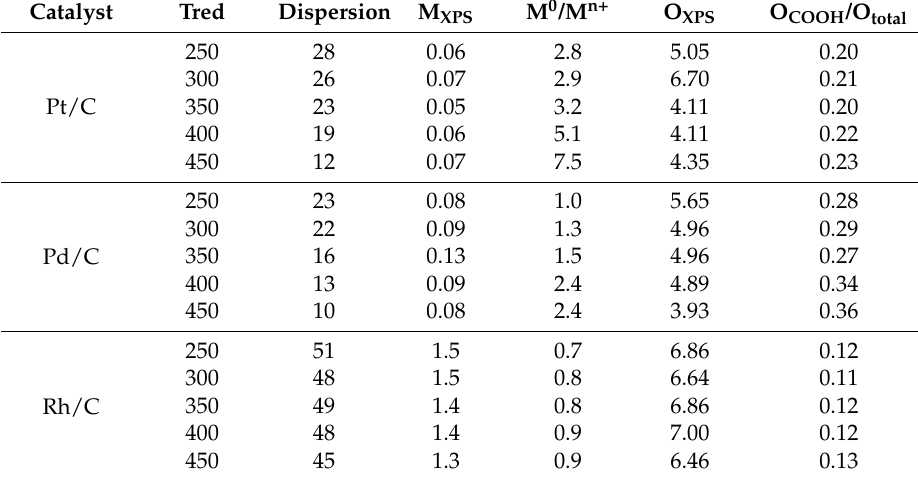
Table 2. Dispersion values, surface metal (M XPS ) and oxygen (O XPS ) atomic concentrations, relative distribution of the surface metallic species (M 0 /M n+ ) and O COOH /O total ratios of the catalysts reduced at different